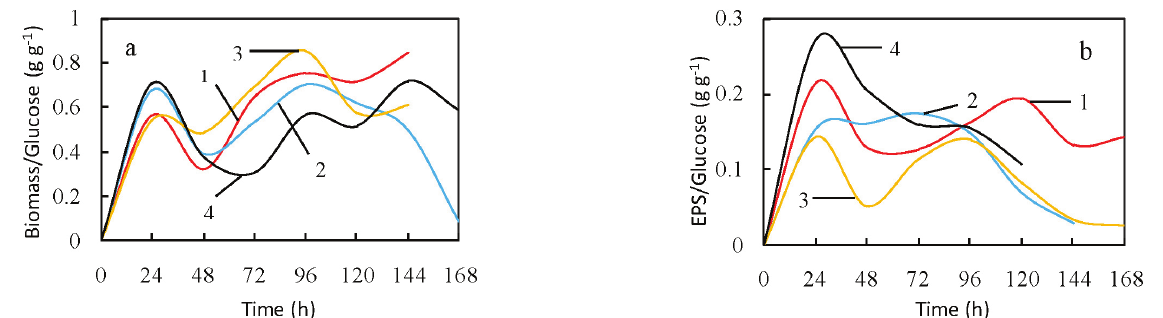
Fig. 4 – Changes in biomass and EPS yields on glucose at different constant pH. pH 4.5 (1), pH 5.5 (2), pH 6.5 (3) and pH 7.5